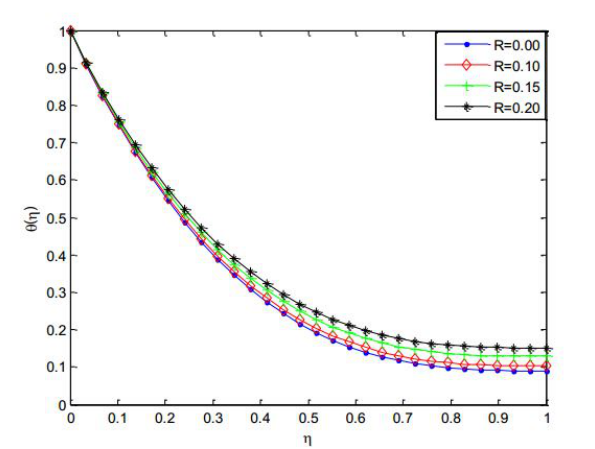
Figure 2. ffects of radiation parameter on the temperature profile of Ag-Kerosene Casson-Carreau nanofluid